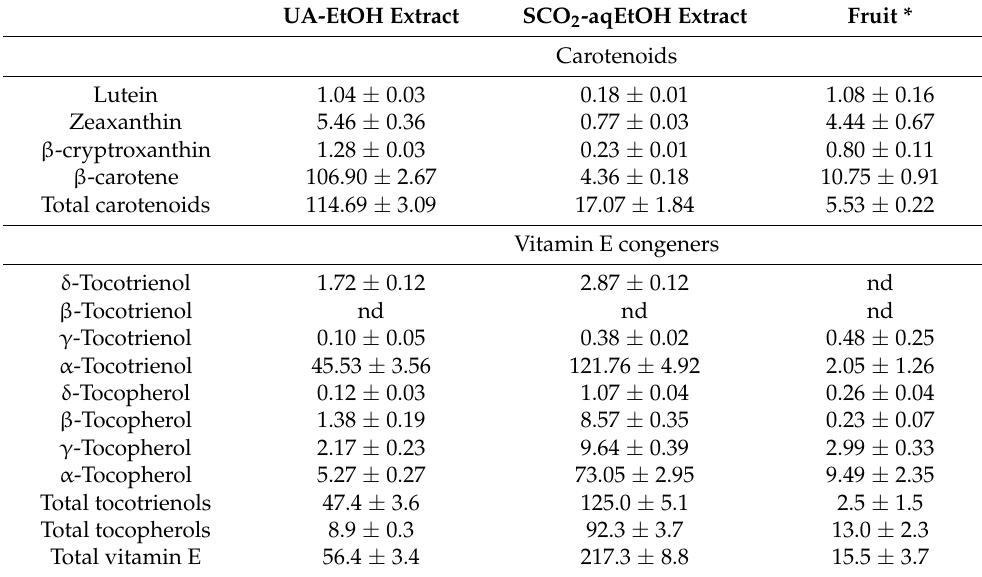
Table 3. Lipophilic compounds ( µ g/g dw) of black rosehip and its extracts obtained using different extraction